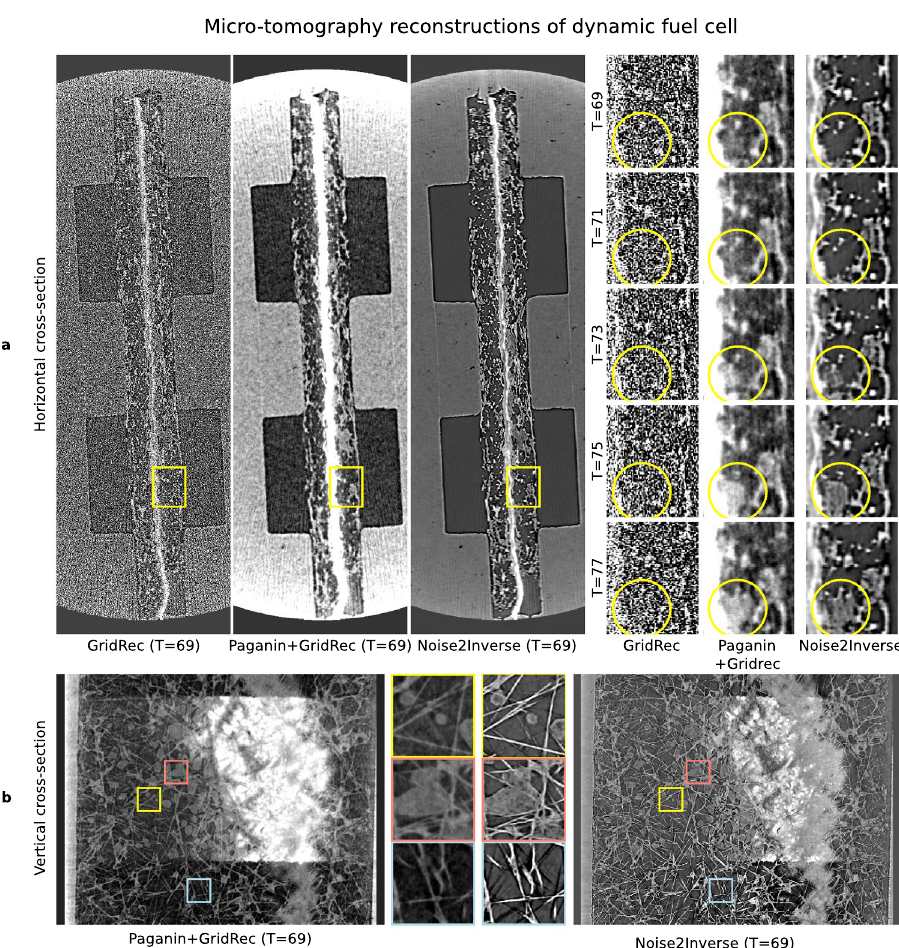
Figure 5. Comparison of reconstructions of an operating fuel cell using GridRec, Paganin+GridRec, and Noise2Inverse. ( a ), Reconstructions of the fuel cell in operation. The yellow region of interest is magnified in the windows on the right, and shows the formation of a water bubble over several time steps. ( b ), A vertical cross- section of the dynamic reconstruction is displayed with magnified regions of interest shown in the